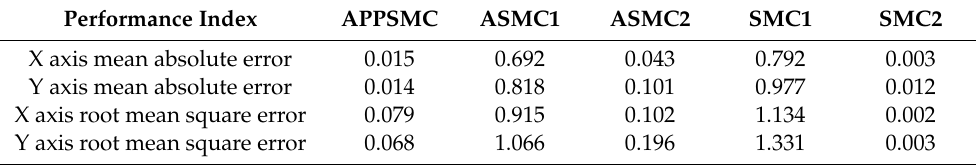
Table 4. Tracking performance comparison of APPSM, ASMC1, ASMC2, SMC1, and SMC2. Performance Index